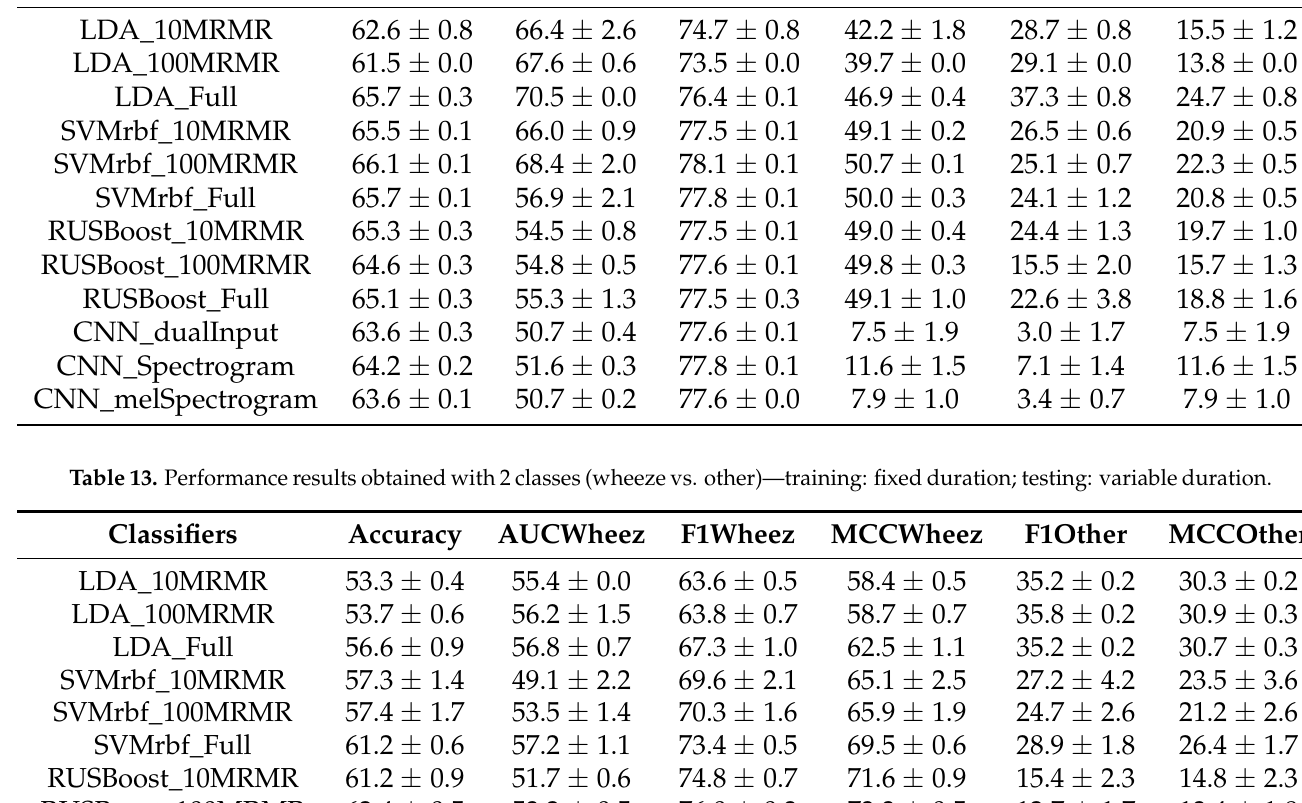
Table 12. Performance results obtained with 2 classes (crackle vs. other)—training: fixed duration; testing: variable duration. Classifiers